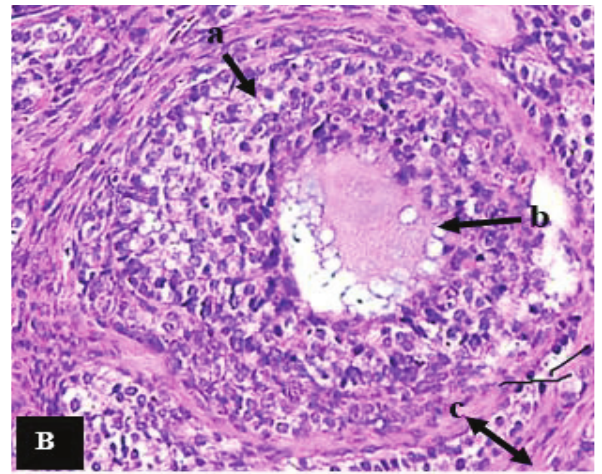
Fig-2B: Smaller sized secondary follicle showing pyknosis (a), vacuolization (b), fibrosis in theca interna and irregular zona pellucida (c).